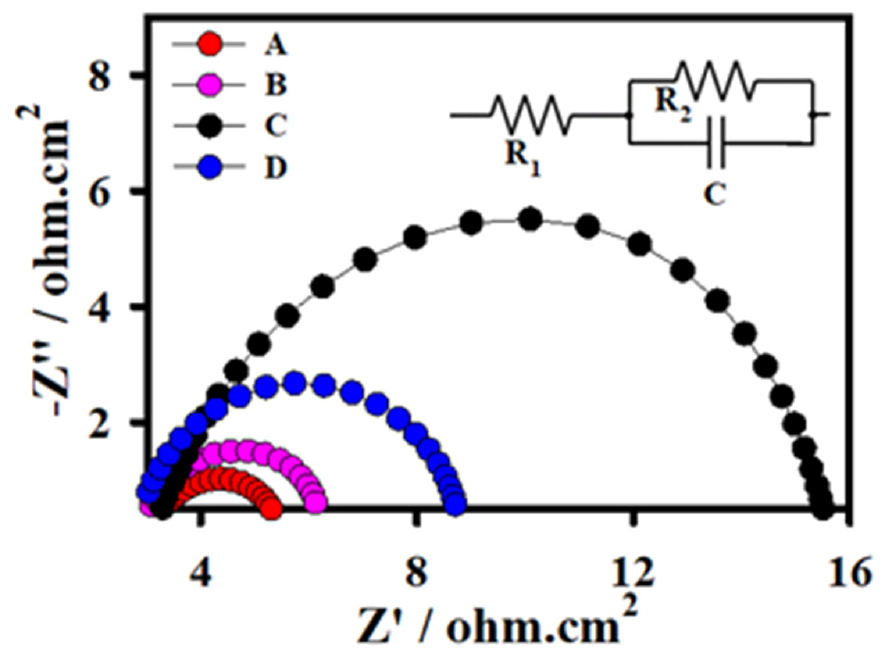
Figure 7. Nyquist plots of the nanostructured PS-3D-FeP@NiO|Ni (A) (red curve), CoP@NiO|Ni (B) (pink curve), NiP@NiO|Ni (C) (black curve), and CuP@NiO|Ni (D) (blue curve) electrodes recorded at the applied potential of ~1.49 V in 1.0 M KOH.